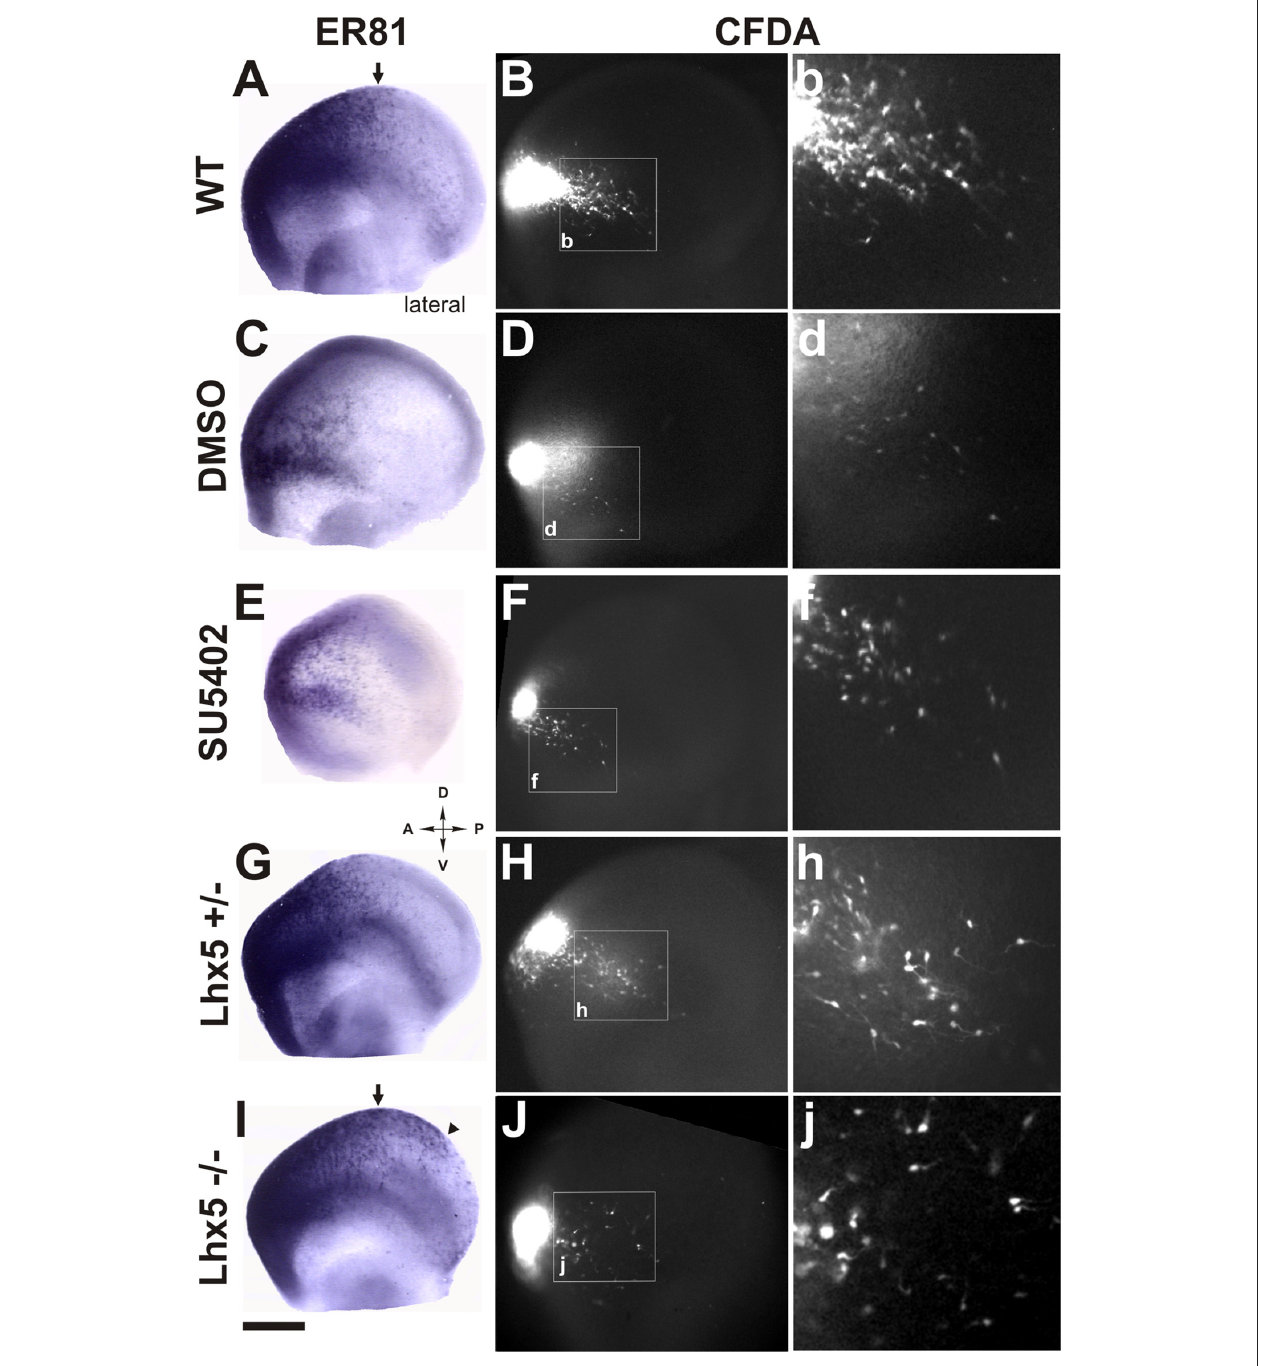
FIGURE 4 | Rld-derived cells do not belong to Er81 or Lhx5 CR cell populations. Er81 in situ hybridization (ISH) was performed in CFDA-labeled embryos (E11.5 + 24 h in culture) in several conditions. (A) Wild-type (WT) embryo showing Er81 expression in rostrolateral and rostrodorsal areas. (B,b) Migration of CFDA-labeled cells in a caudo-ventral direction. (C,D,d) Control embryo (cultured in 0.1% DMSO) showing similar pattern of Er81 expression and direction of migration of CFDA labeled cells as in (A,B) . (E,F) Treatment with the FGF inhibitor SU5402 showing decreased Er81 expression (E) and a reduction in the caudoventral migration of CFDA + migrating cells (F,f) . (G,H,h) Heterozygous Lhx5 mouse embryo showing patterns of both Er81 expression and CFDA-labeled cell migration similar to WT controls (A,B) . (I) Lhx5 knock-out mouse embryo showing an expansion of Er81 expression in dorsocaudal regions. (J,j) Lhx5 mutants showing a slight decrease in the amount of CFDA-labeled cells, and although migration in the caudoventral direction was present, cells appeared to be disorganized. Arrows in (A,I) show the normal limit of Er81 expression; arrowhead in (I) shows expanded Er81 expression in Lhx5 mutants (I) and asterisk shows some dispersed points of Er81 expression. Scale bar: 200 µ